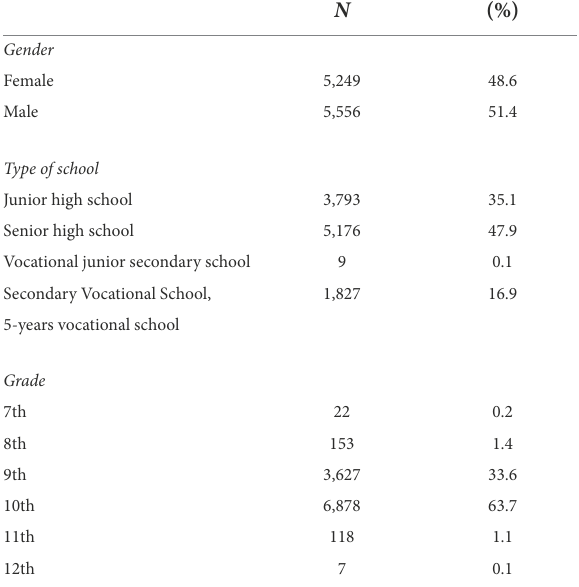
TABLE 1 Distribution of participants ( n =